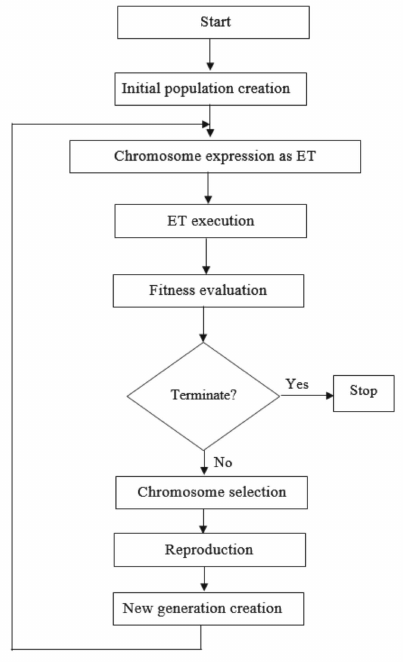
Figure 2. Range of different parameters in the